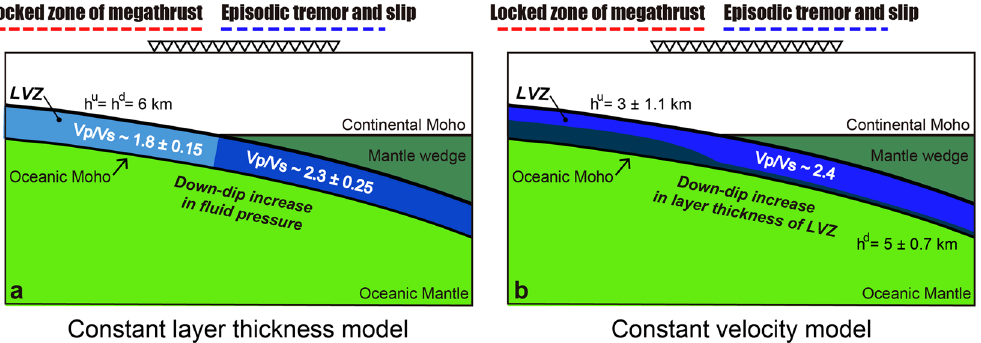
Figure 6. Schematic figures showing depth variations of structural elements in the LVZ, relative to the locations of ETS. ( a) Fluid pressure changes in the LVZ inferred from the constant layer thickness model. ( b) Layer thickness changes in the LVZ derived from the constant velocity model. To evaluate uncertainties for the model parameters, we calculated the standard deviation of the parameters with the cross-correlation coefficient greater than 0.72 for each best-fit model (Figs 4 and